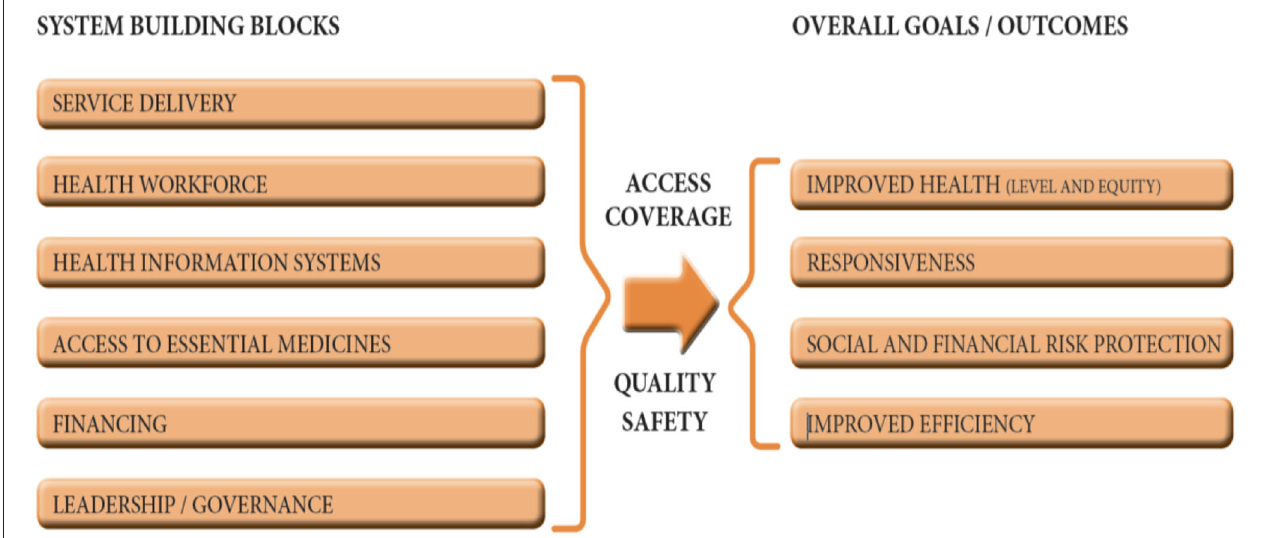
FIGURE 1 | The six building blocks of a health system: aims and desirable attributes. Source: World Health Organization (6).